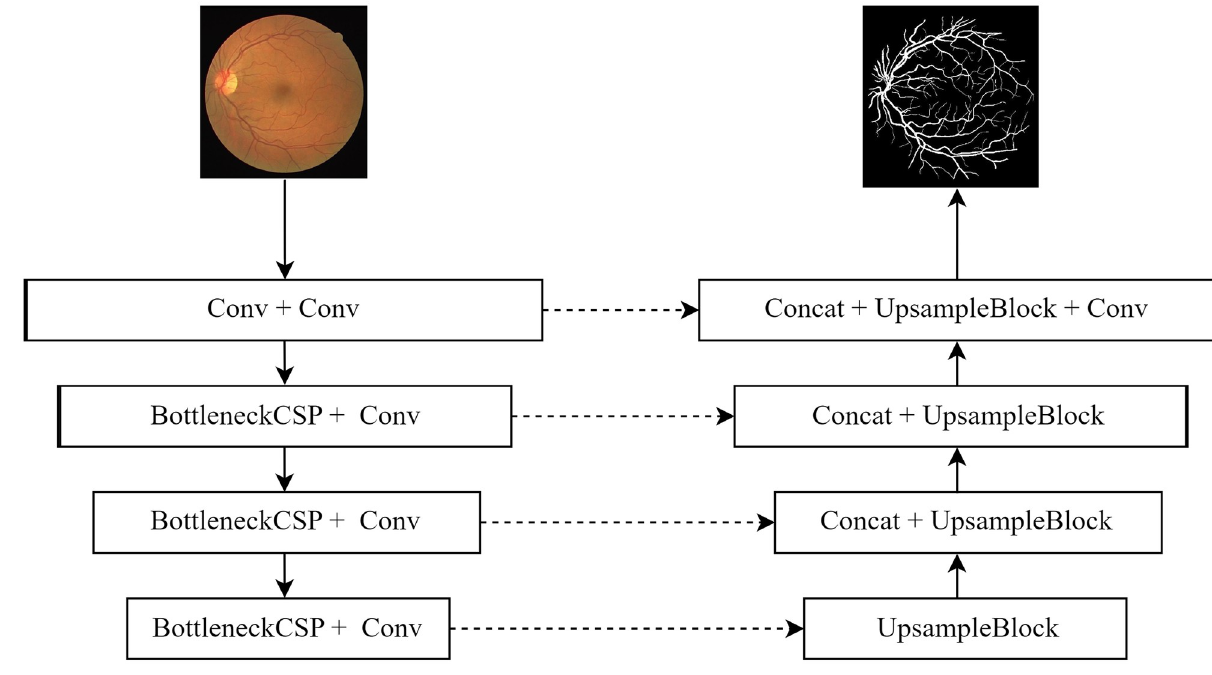
Fig 2. Schematic diagram of CSP_UNet